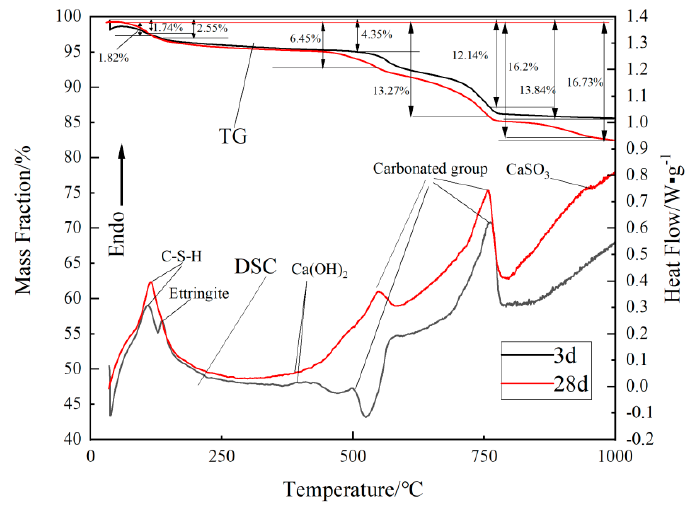
Figure 6. TG–DSC curve of sample 7 obtained at different curing ages at 20 °C.